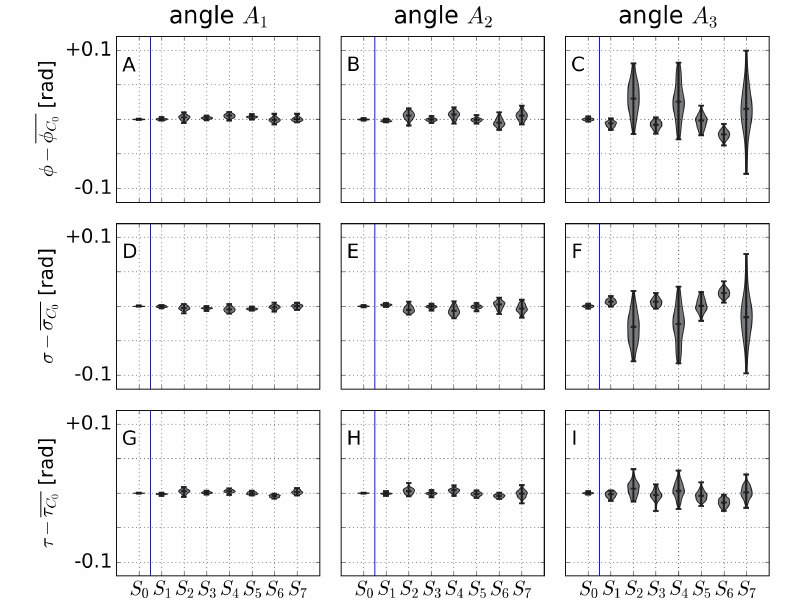
Figure 13. Demeaned camera Eulerian angles φ , σ , and τ for angles A 1 ( A , D , G ), A 2 ( B , E , H ), and A 3 ( C , F , I ) for model M 2